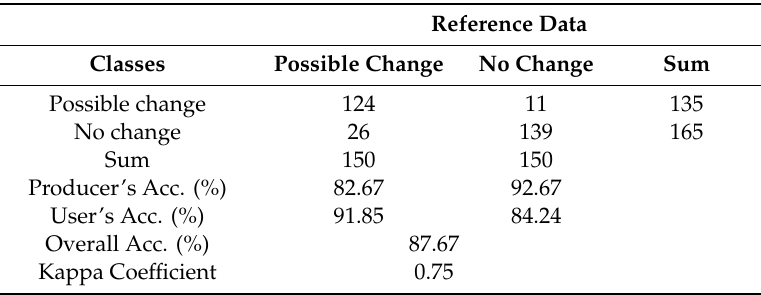
Table 7. The accuracies of change detection in Method 1 and Method